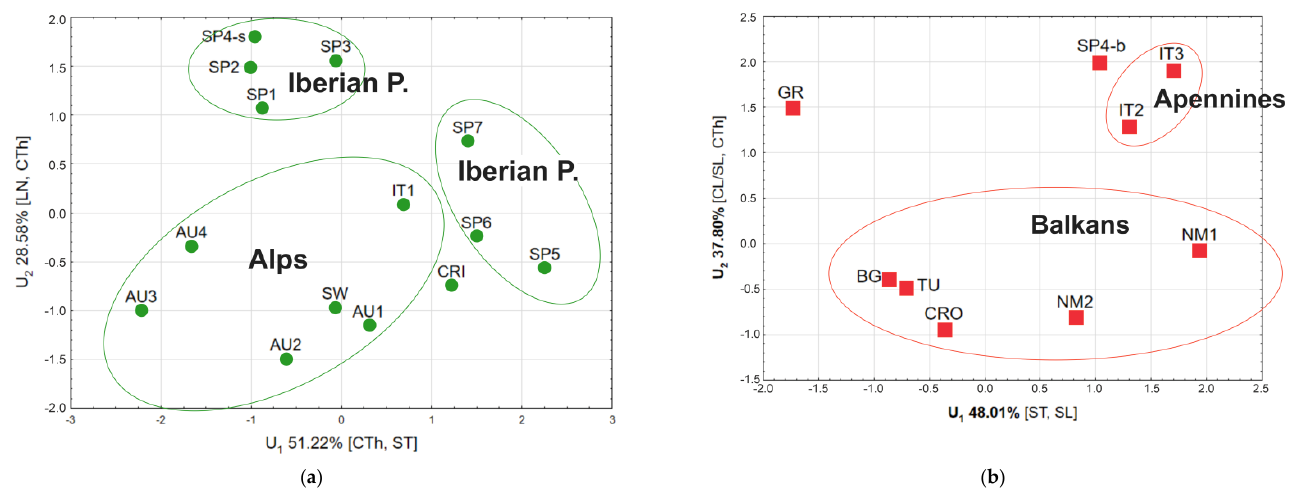
Figure 4. Scatterplots showing results of discrimination analysis of J. sabina ( a ) Samples means of the variety sabina . ( b ) Samples means of the variety balkanensis . In square brackets − codes of characters the most strongly connected with the discriminant variable. Samples acronyms as in Table 1.